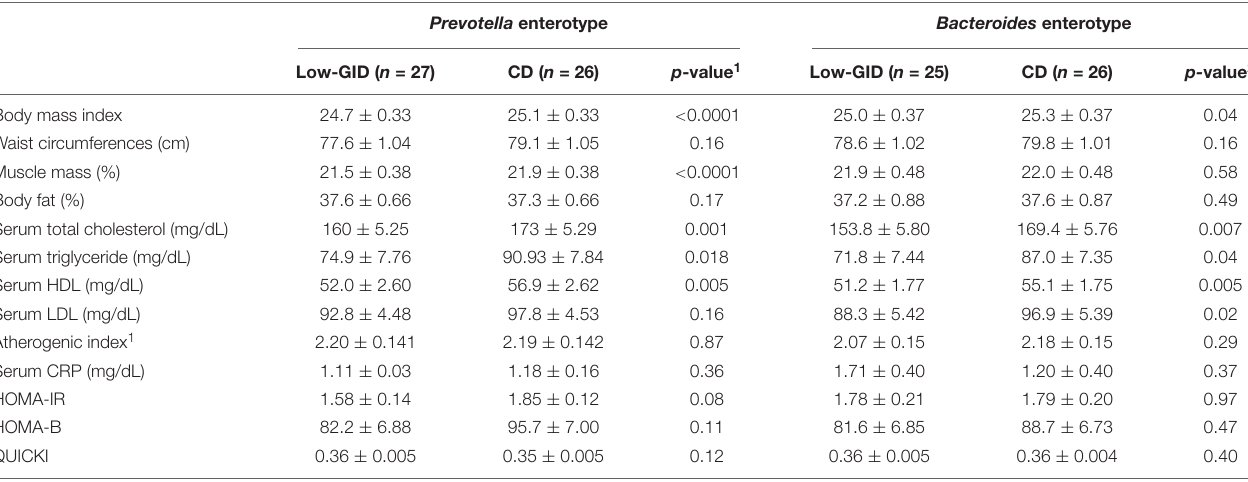
TABLE 3 | Anthropometric and serum biochemical index of the participants according to Prevotella and Bacteroides enterotypes after the intervention of a low-glycemic diet (Low-GID) representing Korean traditional balanced diet and westernized diet as control diet